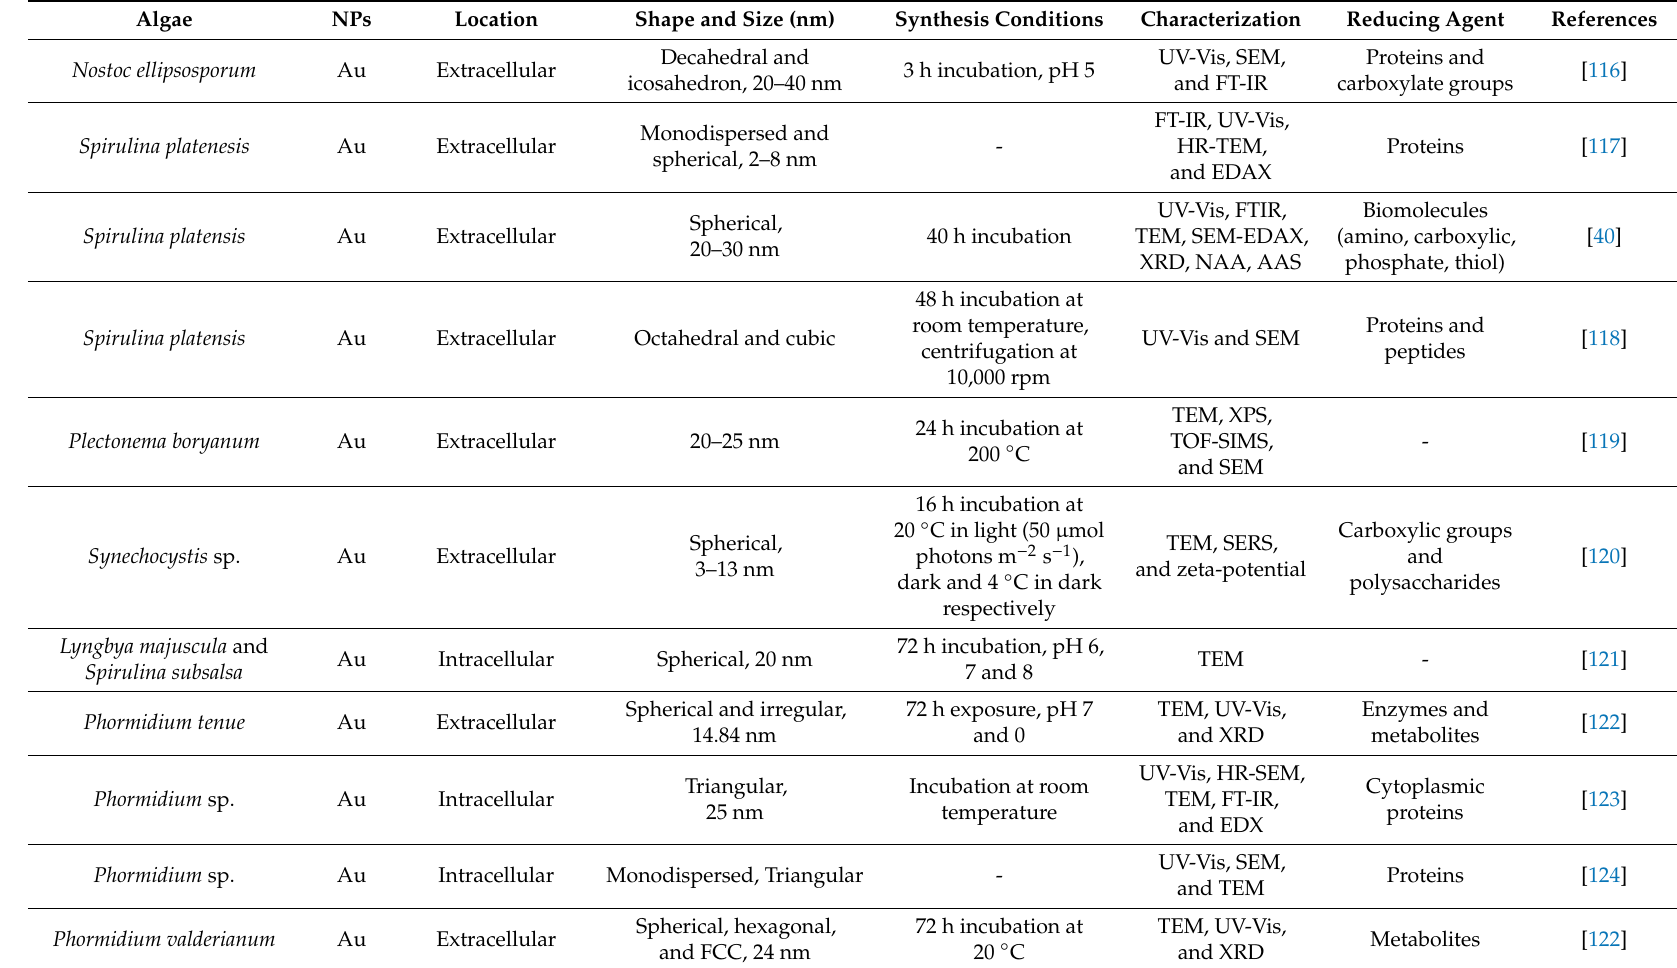
Table 3. Blue-green algae-mediated biosynthesis of